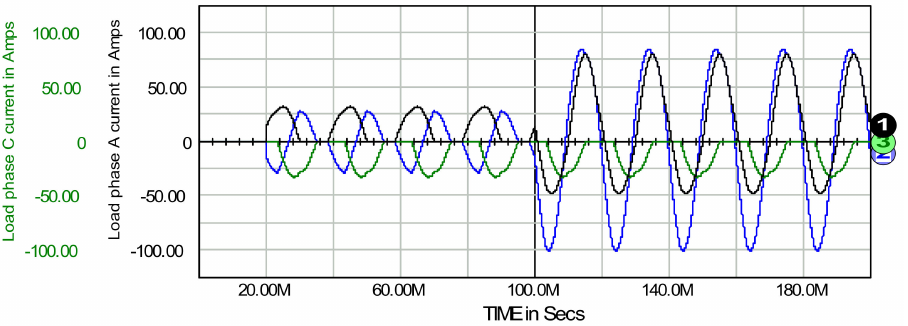
Figure 5. Load phase currents of phase A, B and C: waveforms 1, 2 and 3, respectively. The load passive part is switched on at t 1 = 20 ms, and the generative part is activated at t 2 = 100 ms.